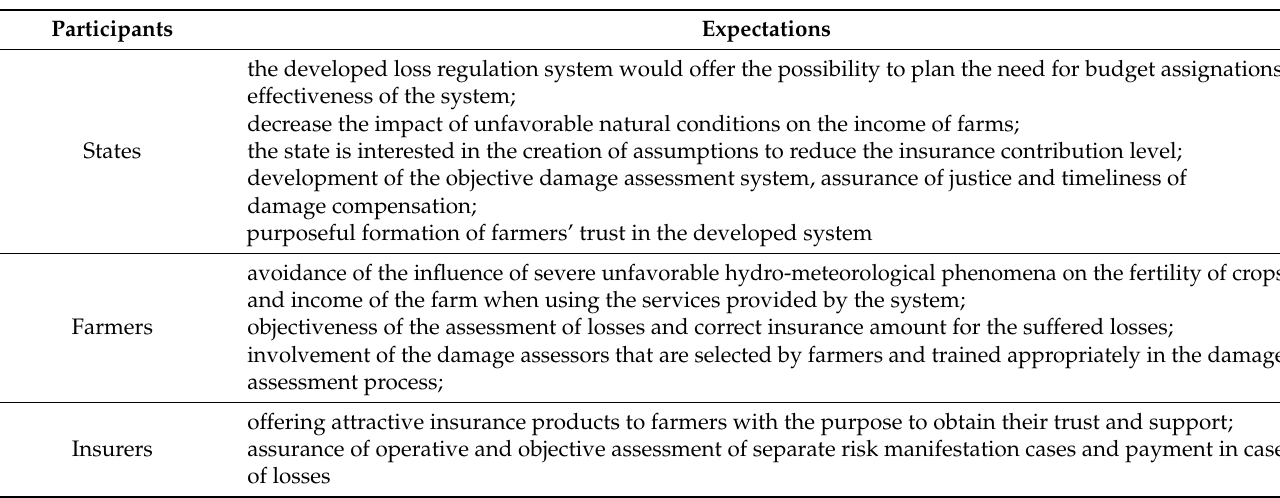
Table 2. Expectations of the participants of the crop insurance system.